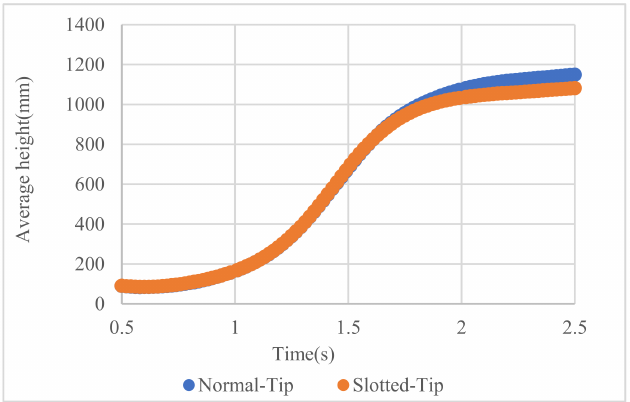
Figure 21. Comparison of average height of particles in different blades by time.